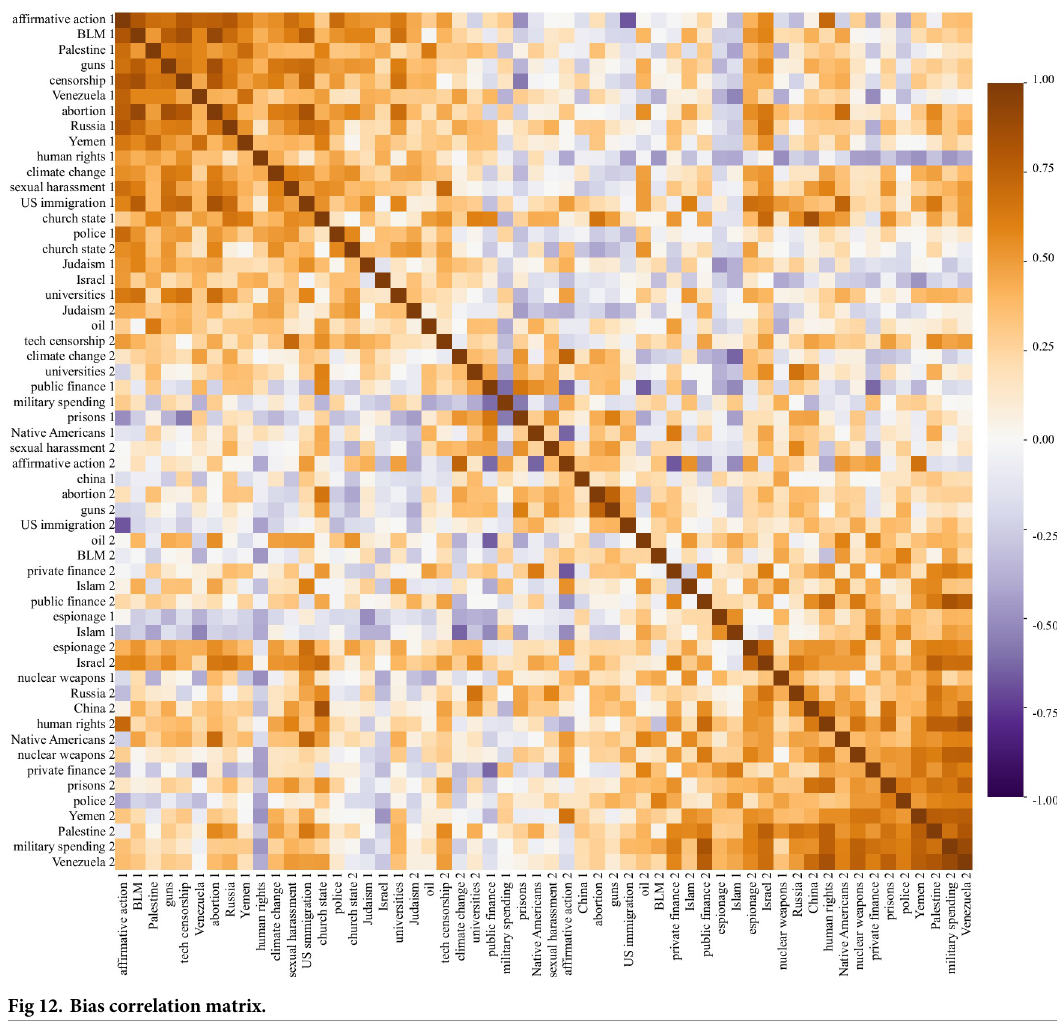
Fig 12. Bias correlation